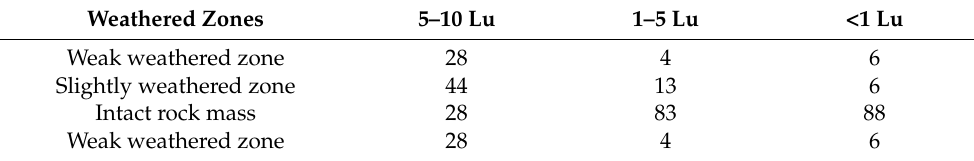
Table 1. Percentage of Lu values for different weathering zones